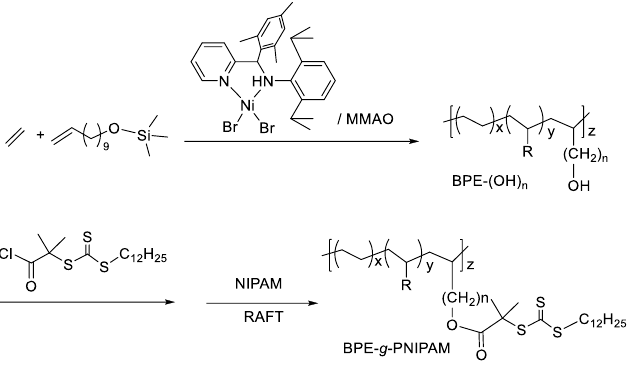
Scheme 9. Synthesis of the BPE- g -PNIPAM graft copolymer.